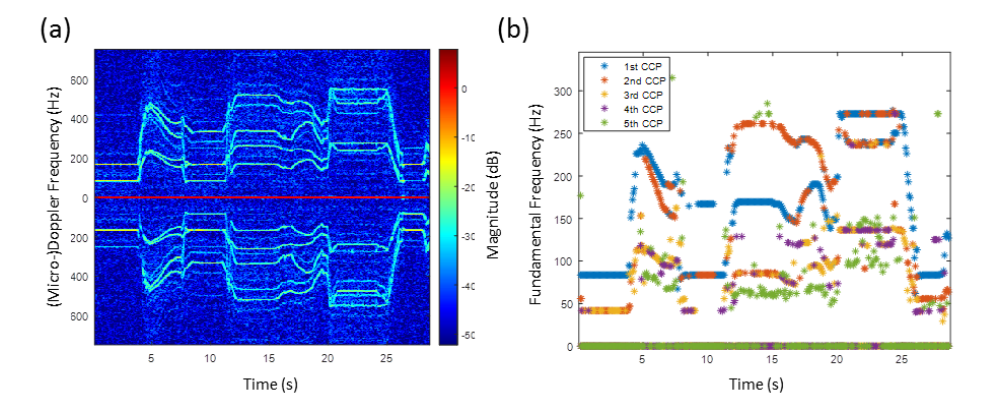
Figure 8. ( a ) HERM lines spectrogram for hexacopter measured by C-band radar; ( b ) corresponding multi-frequency detector